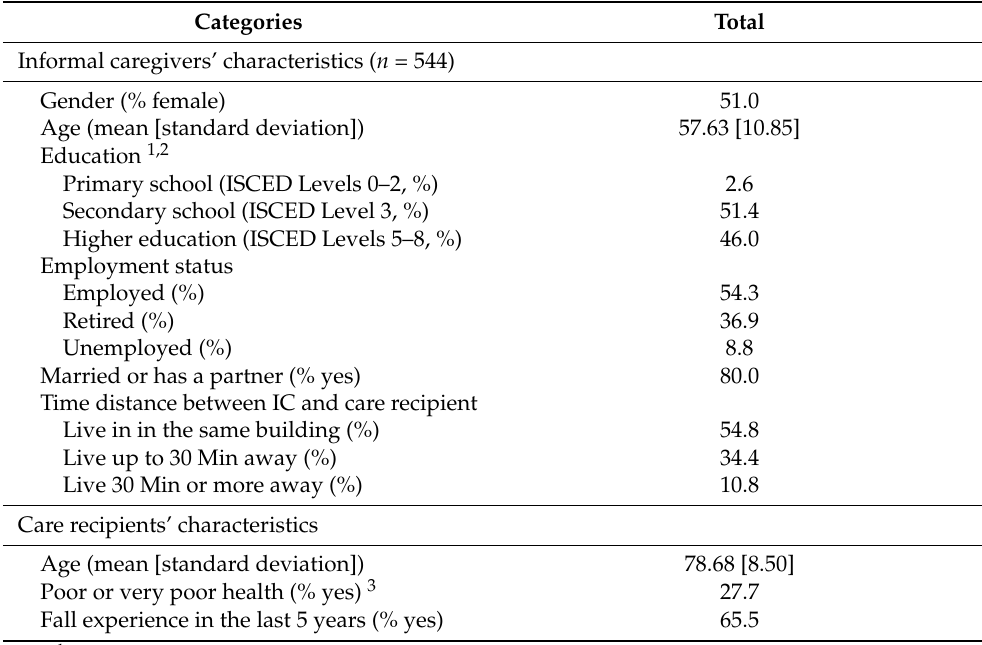
Table 1. Characteristics of informal caregivers and their care